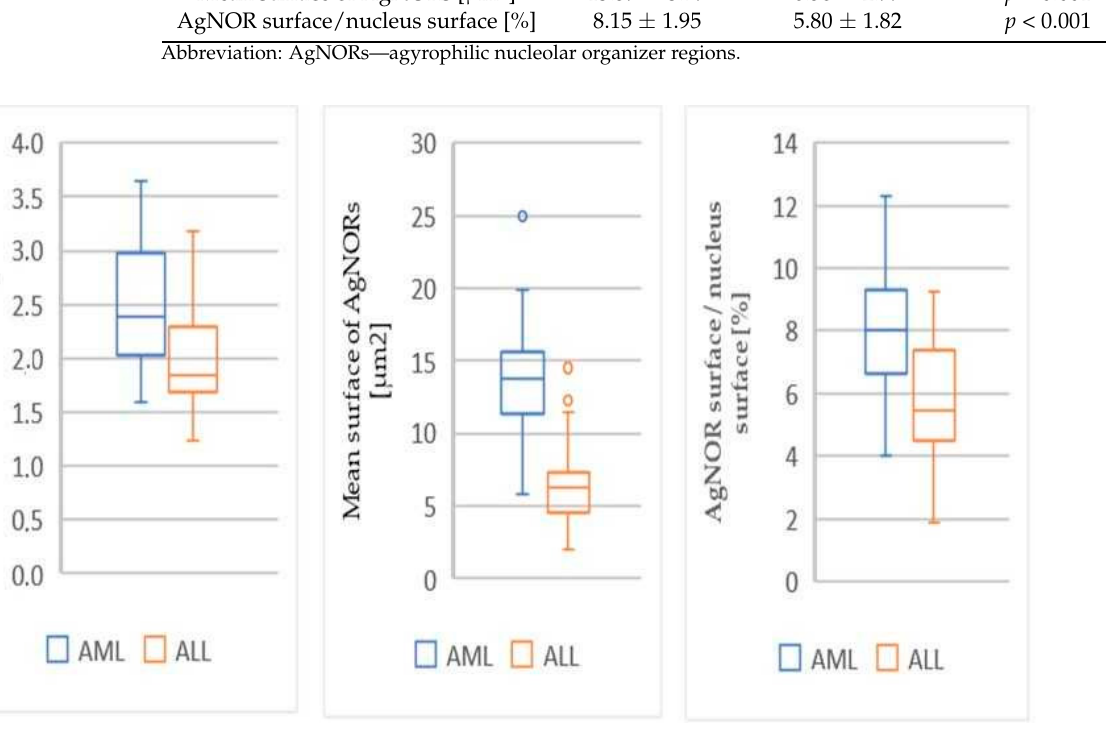
Figure 2. AgNOR indexes differences between AML and ALL: the mean number, mean surface area, and mean ratio of AgNOR surface area to nucleus surface area. Table 1. AgNOR indexes in AML and ALL: the mean number, mean surface area, and mean ratio of AgNOR surface area to nucleus surface area, expressed as percentages in AML and ALL.